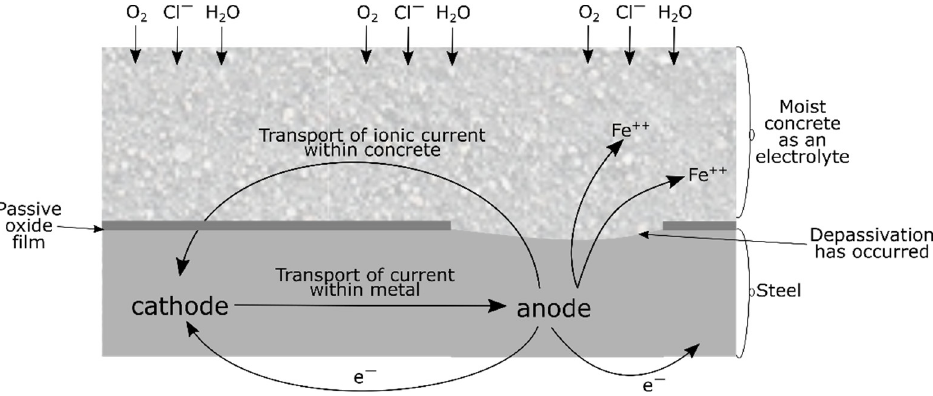
Figure 1. Schematic of chloride-induced steel corrosion in concrete.